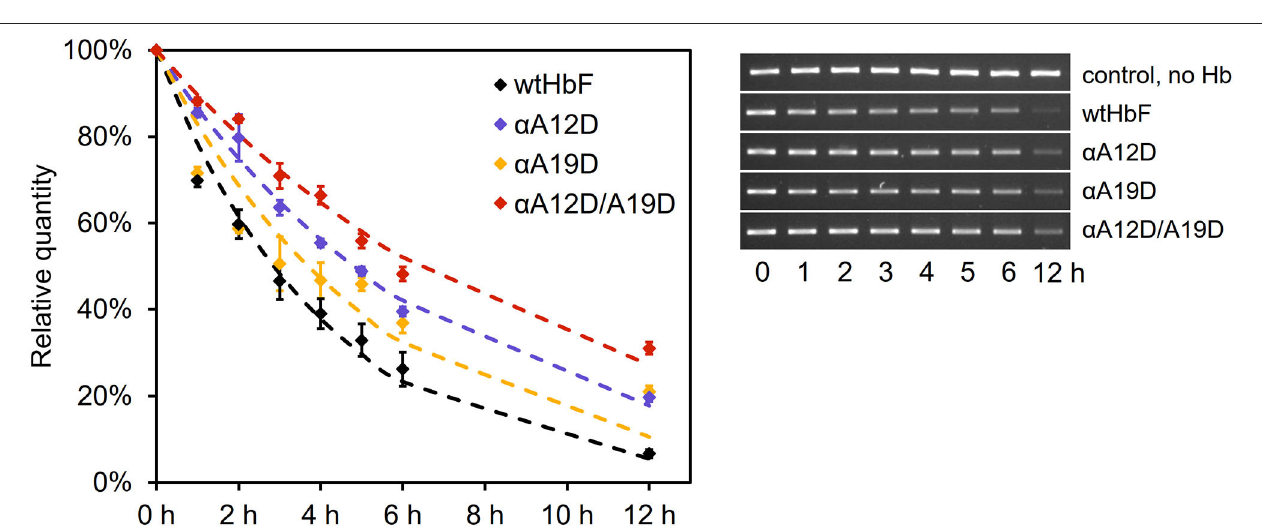
FIGURE 3 | DNA cleavage of 3 ng/ µ l pUC18 plasmids incubated with 75 µ M Hb of the different HbF mutants at 37 ◦ C in 20mM phosphate buffer pH 7.2. The graph shows the mean values of the remaining DNA content, with error bars representing the standard deviation, together with the fitted curves of the exponential decay (dashed lines). Statistical differences were determined by independent t -test ( p < 0.05). The pictures of the gel bands show the supercoiled band over time.